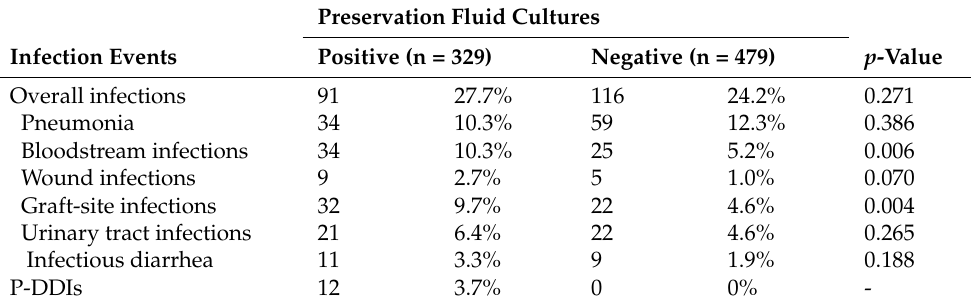
Table 2. Impact of cultures outcomes in preservation fluid on early infection-related events after kidney